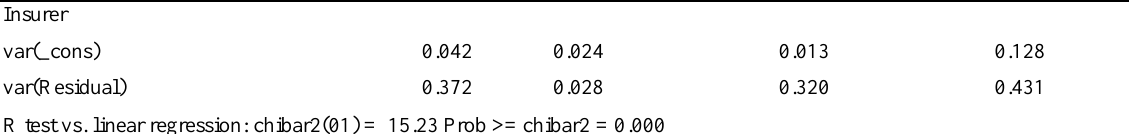
Random-effects Parameters